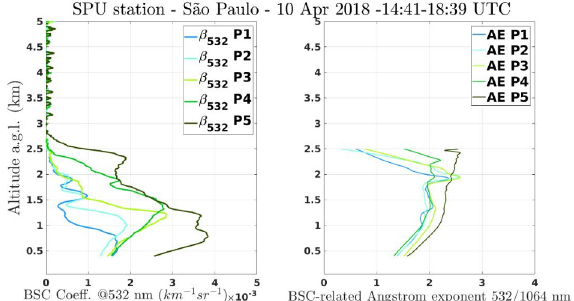
Figure 3: Lidar backscatter profile at 532 nm and backscatter-related Ångström exponent-532/1064nm.